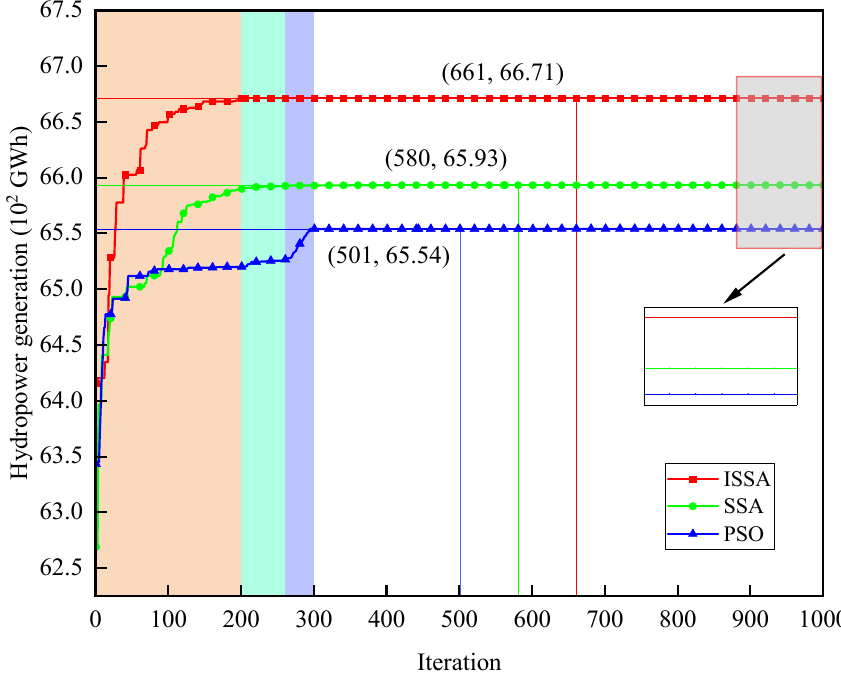
Figure 10. Convergence curves of ISSA, SSA, and PSO for optimal operation.